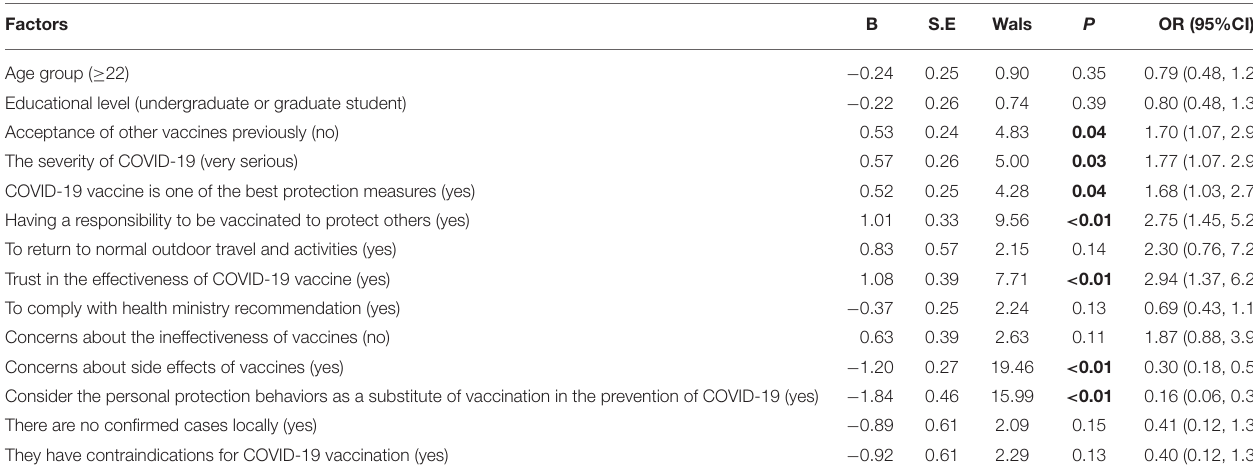
TABLE 3 | Factors associated with acceptance of COVID-19